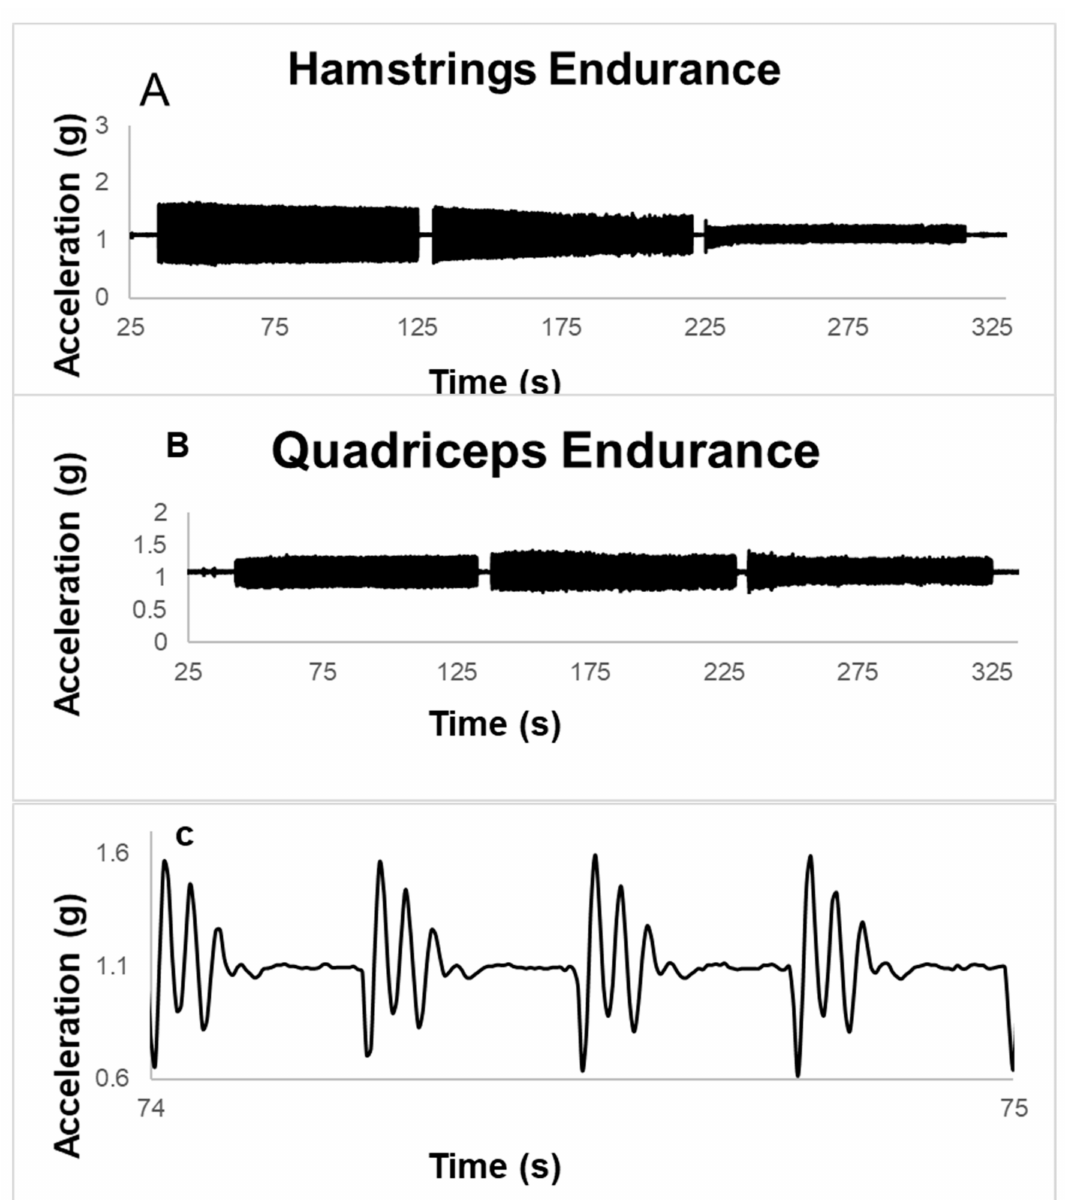
Figure 1. ( A ) A representative example of hamstrings endurance of the injured leg at 2 Hz, 4 Hz, and 6 Hz stimulation. ( B ) A representative example of quadriceps endurance of the injured leg at 2 Hz, 4 Hz, and 6 Hz stimulation. ( C ) Example of peak to peak twitch acceleration zoomed in one second at 4